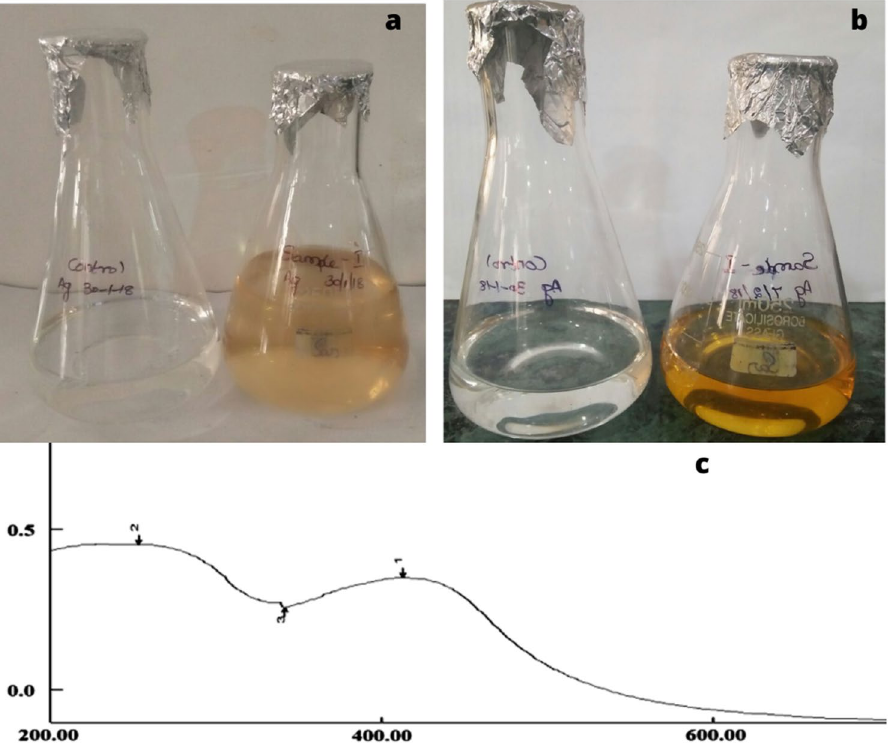
Figure 1. Biosynthesis of silver nanoparticles. ( a ) Before incubation. ( b ) After 48 h of Incubation and ( c ) UV– visible spectrophotometry of silver nanoparticles synthesized from extract of Sargassum